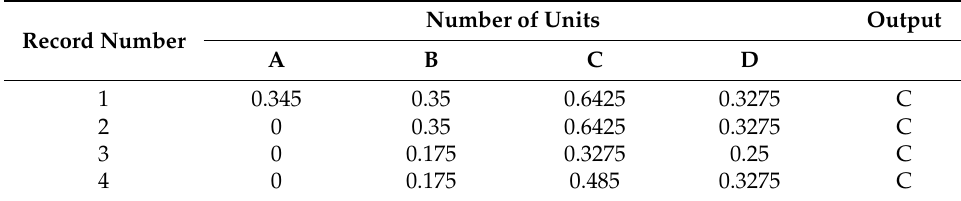
Table 9. The result obtained by improving method 1.